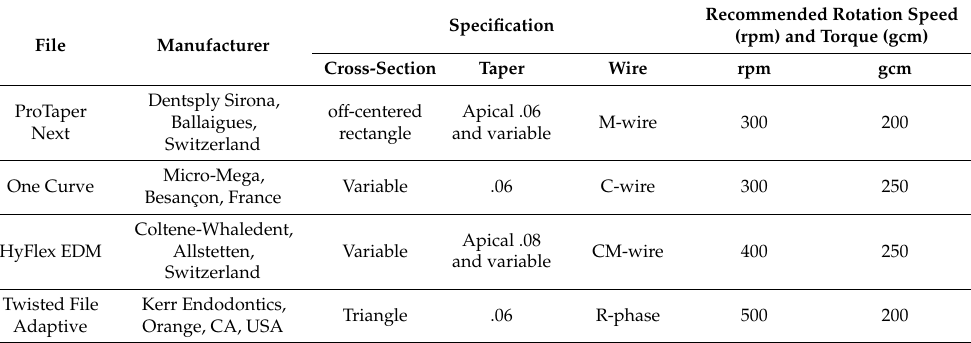
Table 1. Specification of tested files and recommended rotational speed and